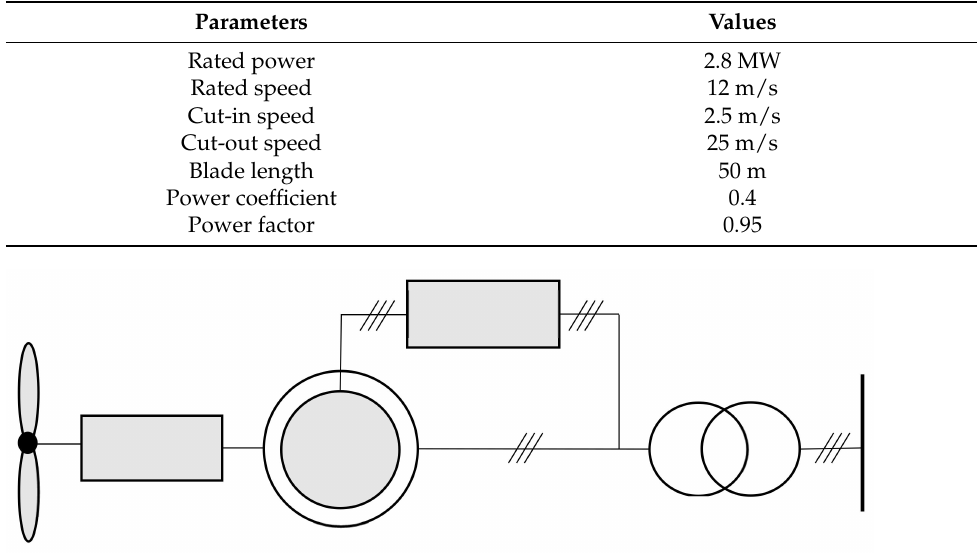
Figure 6. Wind turbine with doubly fed induction